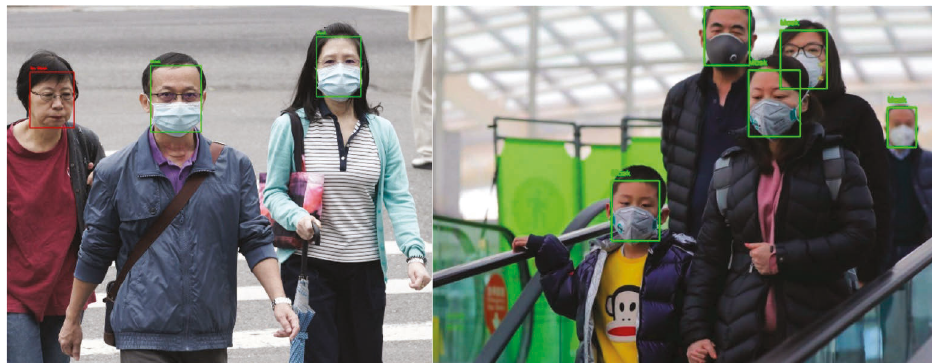
Figure 21: Result of the image after running on the